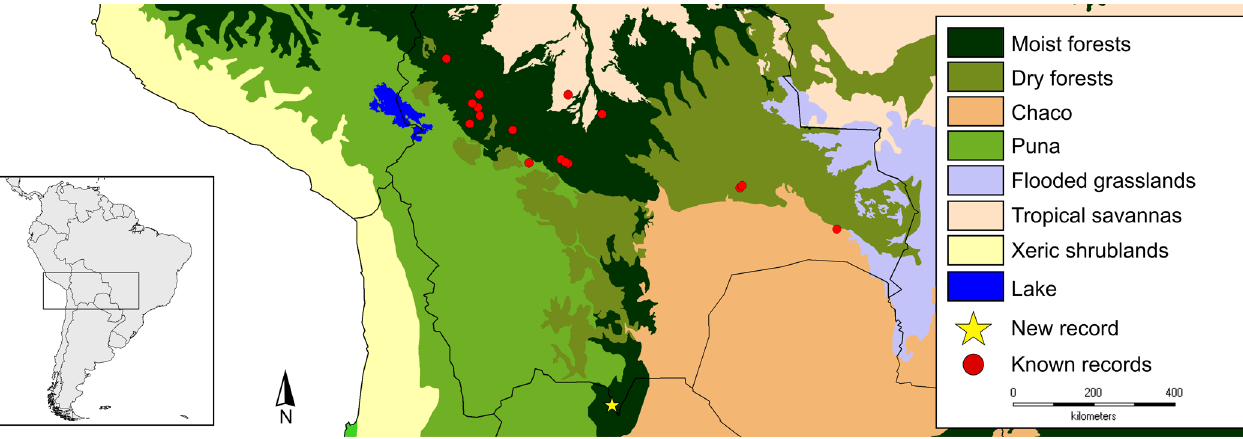
Figure 3. Known geographic distribution and associated ecoregions of